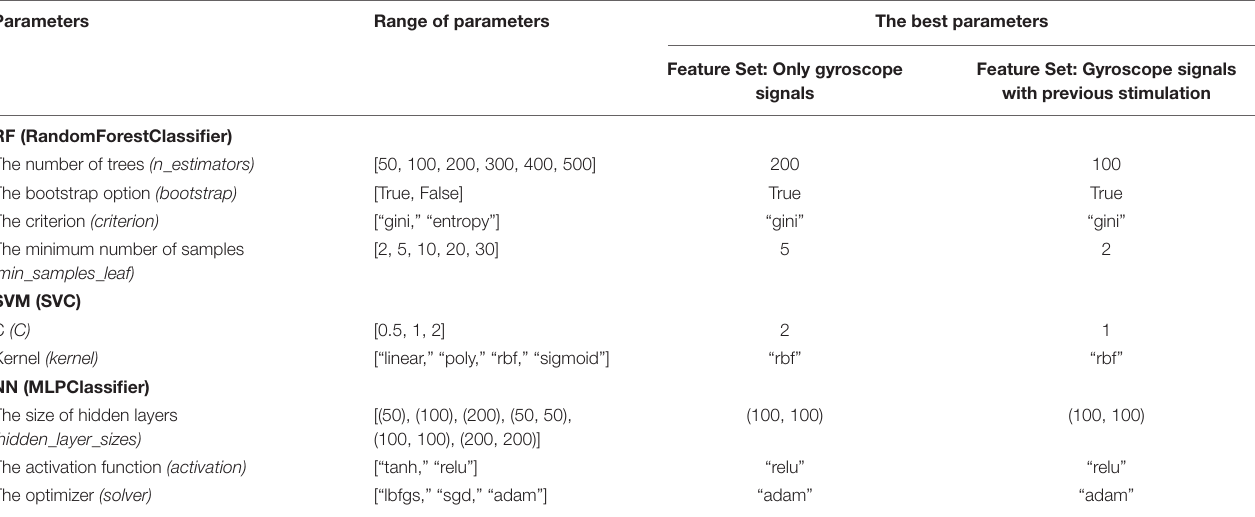
TABLE 6 | Choices of parameters used in the grid search for RF, SVM, and NN on both feature sets.